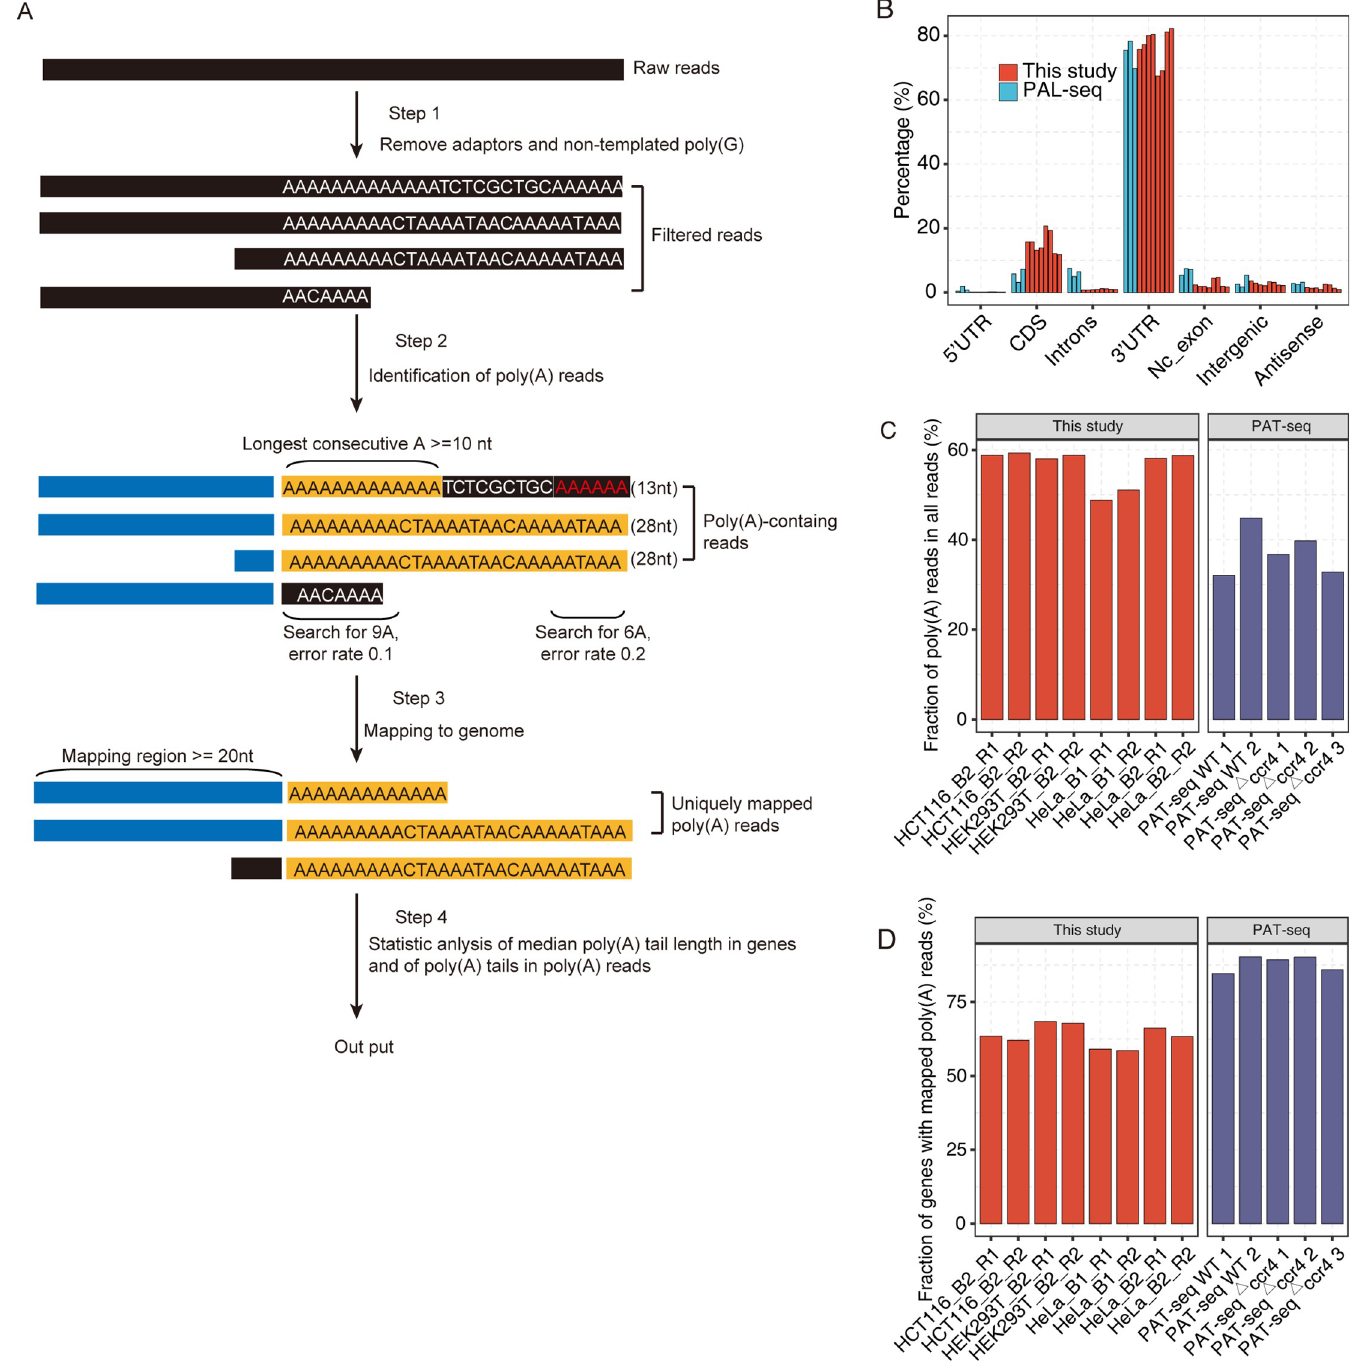
Fig 2. pA-finder identification of the poly(A)-containing reads and the poly(A) tail length of each gene. A. Flowchart of pA-finder. B. Genome distribution of the uniquely mapped reads in Poly(A)-seq, PAL-seq and TAIL-seq samples. C. Percentage of poly(A)-containing reads out of all raw reads of Poly(A)-seq and PAT-seq samples. D. The number of genes with poly(A)-containing reads detected by Poly(A)-seq and PAT-seq.